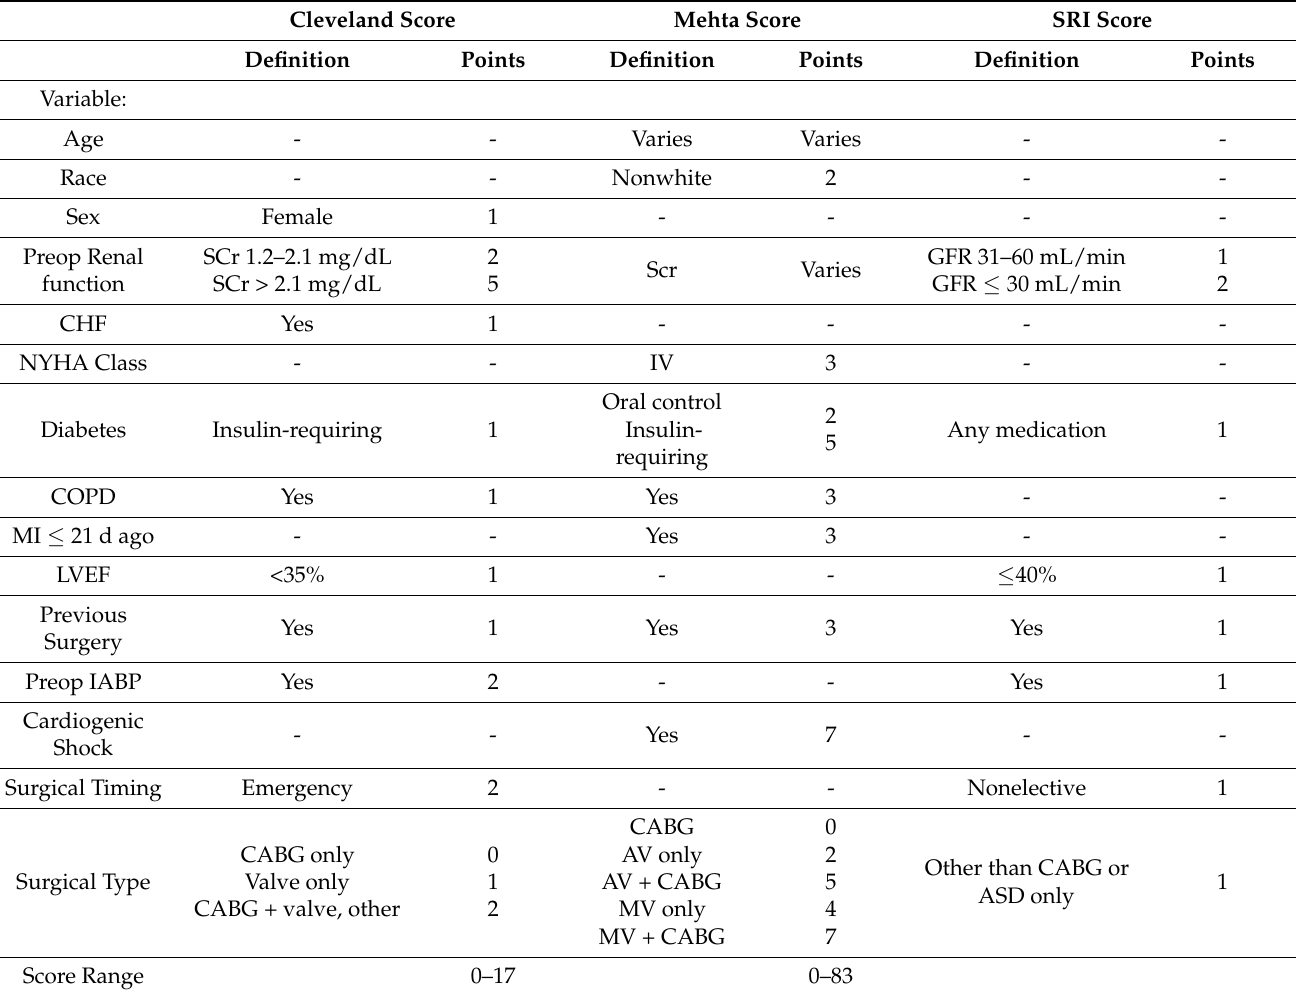
Table 3. Scoring systems for AKI (adapted from